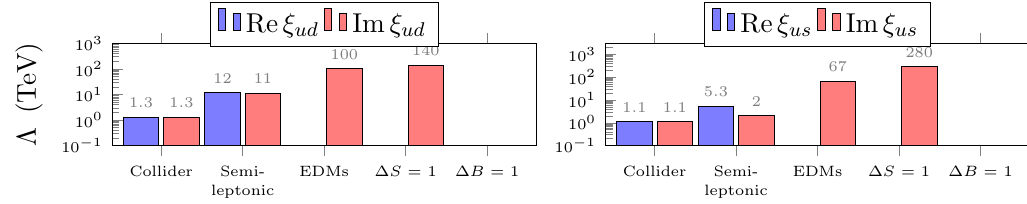
Figure 6 . The (cid:12)gure shows naive constraints on the real (in blue) and imaginary (in red) parts of (cid:24) ud and (cid:24) us converted to an e(cid:11)ective scale (cid:3) by using (cid:24) ij (cid:17) v 2 = (cid:3) 2 . These limits are obtained by setting the CKM parameters to the values of ref. [71], and turning on only one real or imaginary part of (cid:24) ij at a time. In the cases where the bounds are asymmetrical, we show the limit that results